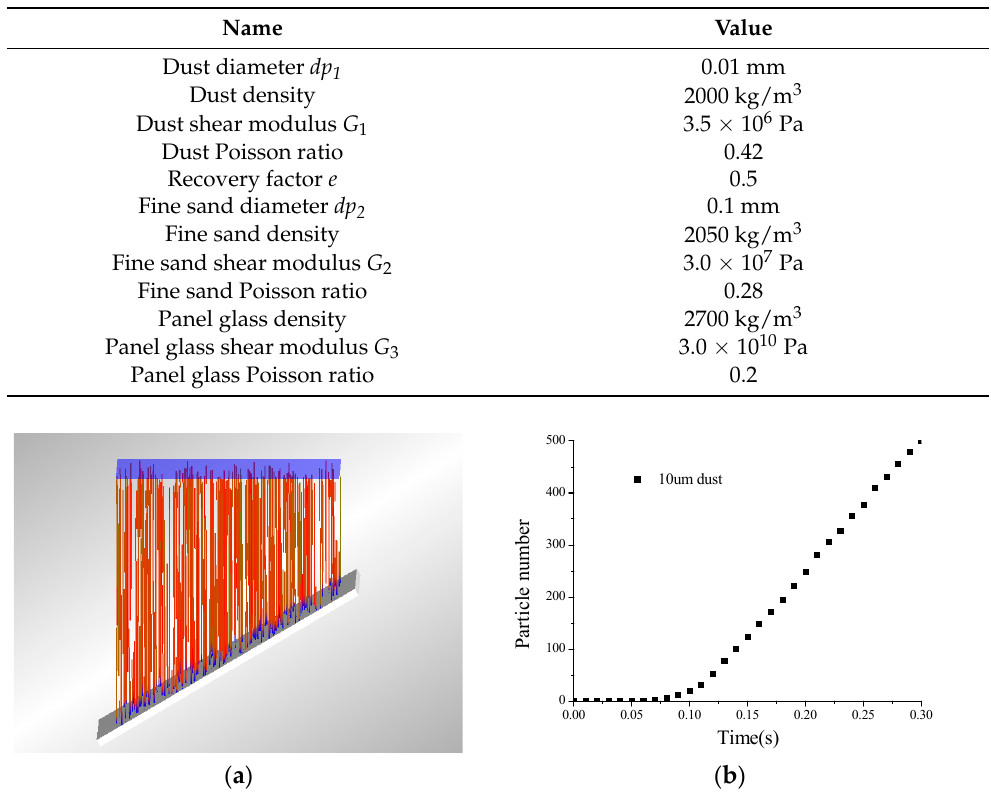
Table 1. Physical parameters of dust particles.